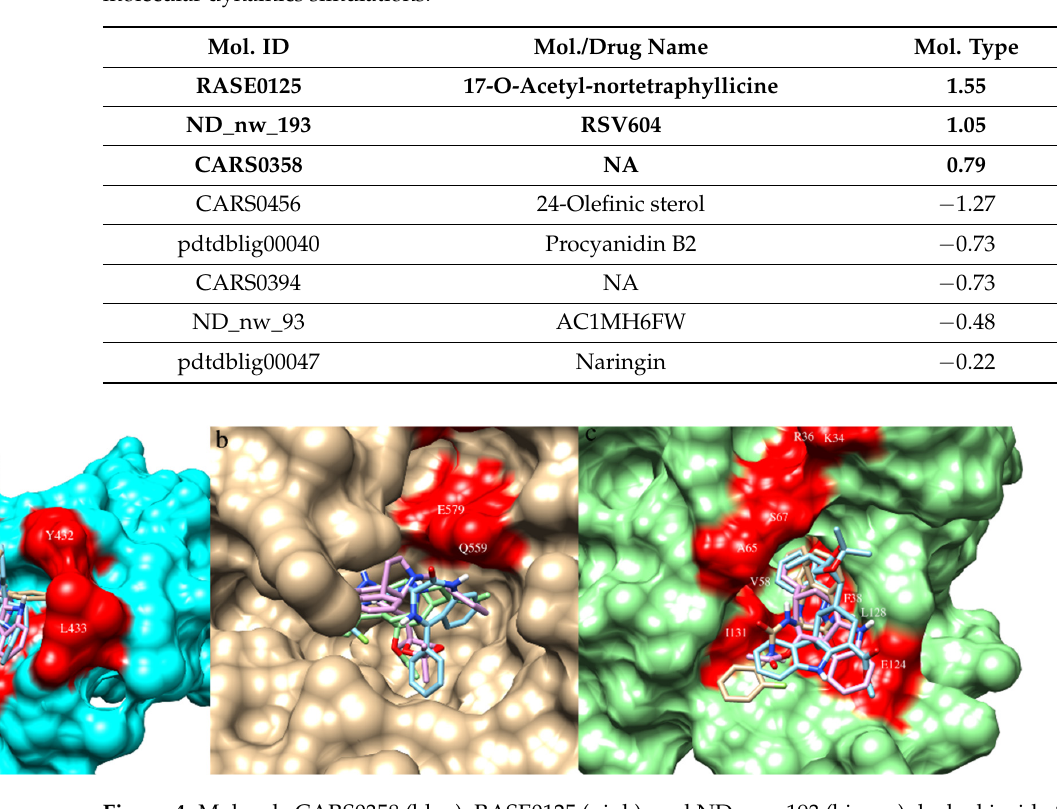
Figure 3. Two-dimensional (2D) images of molecules CARS0358 ( a ), RASE0125 ( b ), and ND_nw_193 ( c ). Table 2. ADME-based z-scores for each molecule. Bolds are the top-ranked molecules selected for molecular dynamics simulations.